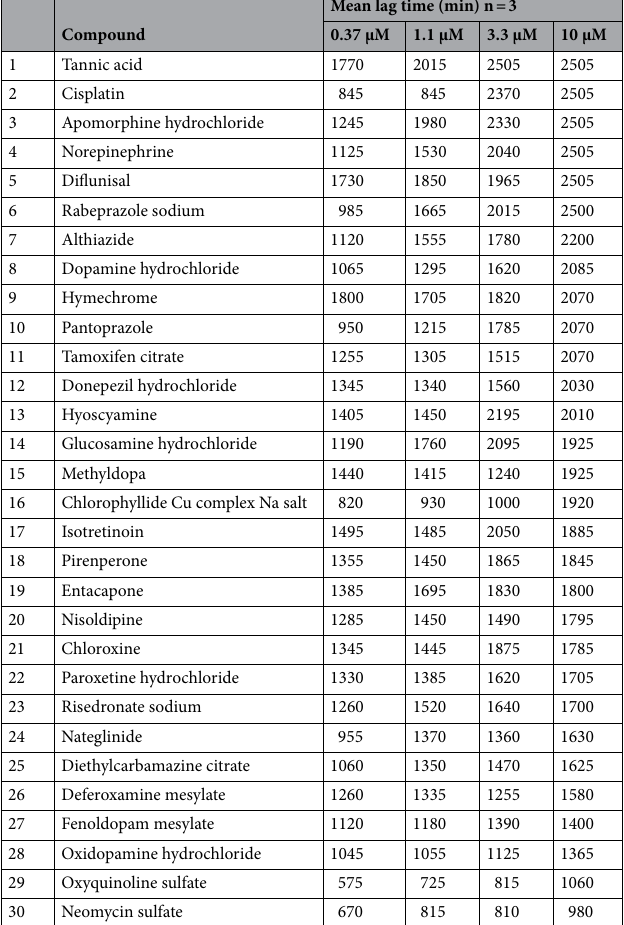
Table 1. Top 30 hit compounds identified in the ThT screening assay for αSyn fibrillation